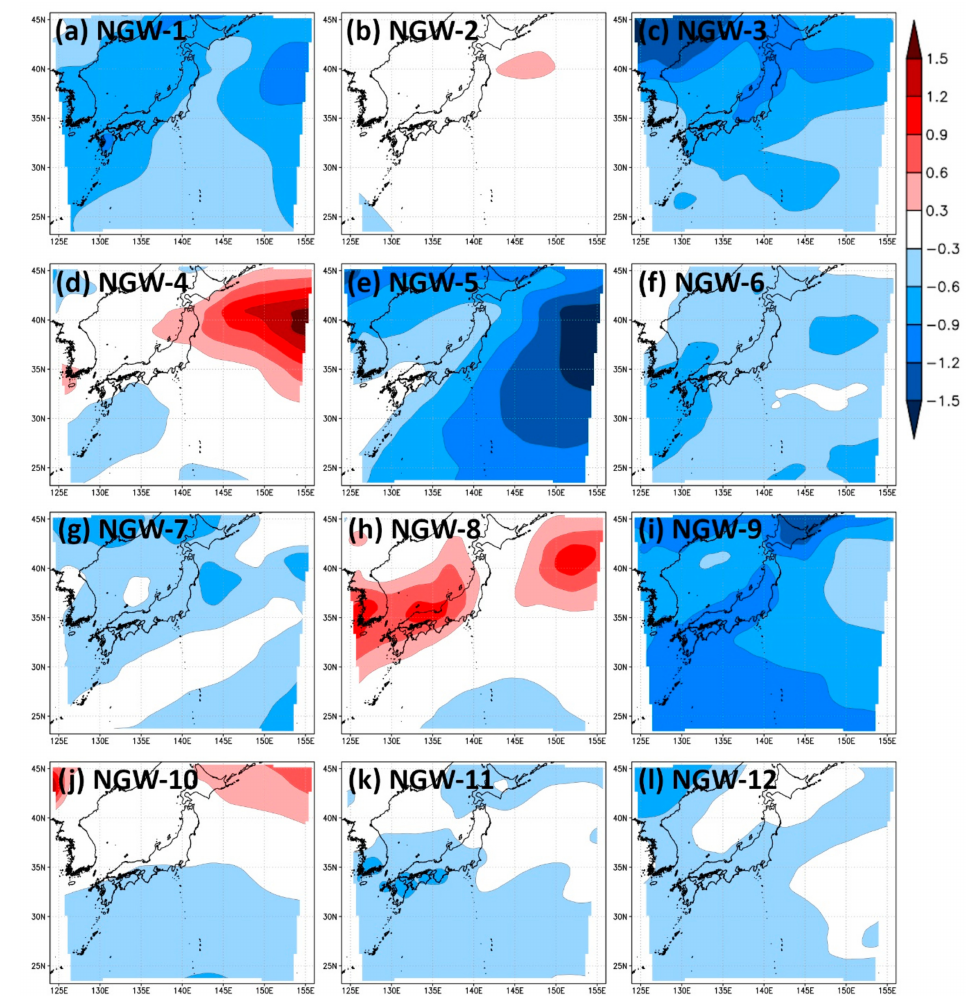
Figure 11. Di ff erence in atmospheric temperature 2 m above the Earth’s surface under initial conditions between each NGW simulation and the hindcast. Result ( a ) NGW-1, ( b ) NGW-2, ( c ) NGW-3, ( d ) NGW-4, ( e ) NGW-5, ( f ) NGW-6, ( g ) NGW-7, ( h ) NGW-8, ( i ) NGW-9, ( j ) NGW-10, ( k ) NGW-11, ( l ) NGW-12. The unit of the color bar is